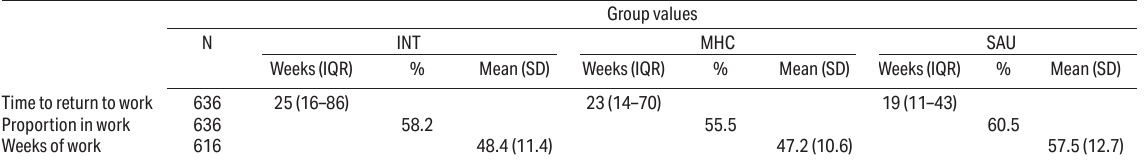
Table 2a. Vocational outcomes at 24-month follow-up: group values. [MHC=mental healthcare; SAU=service as usual; INT=IBBIS integrated inter- vention; IQR=interquartile range; CI=confidence interval.]